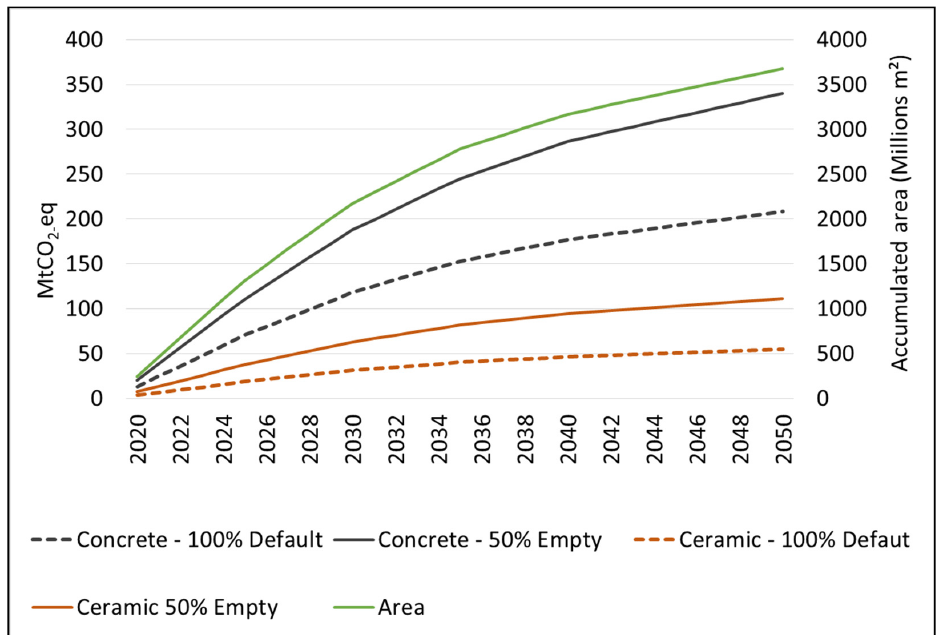
Figure 12. CO 2 -eq emissions considering the housing deficit projection; 100% Default—represents that the truck is loaded with 100% of its capacity and returns full; 50% empty—represents that the truck is loaded with 50% of its capacity and returns empty.